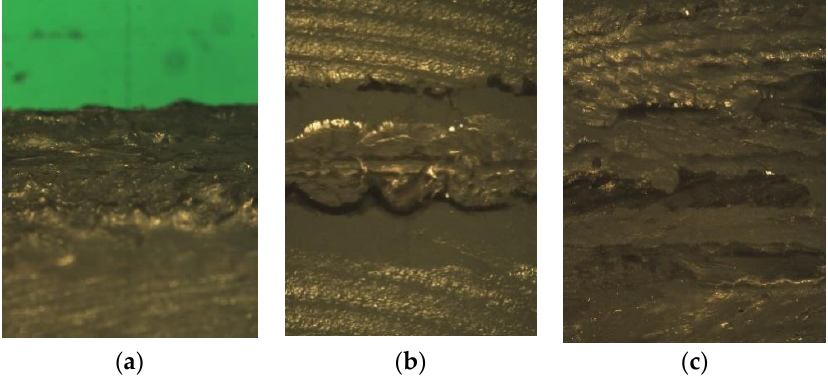
Figure 5. Examples of pictures of the weld beads taken during optical microscope observations: ( a ) 45° scarf joint; ( b ) single-bead lapjoint; ( c ) double-bead lap joint.